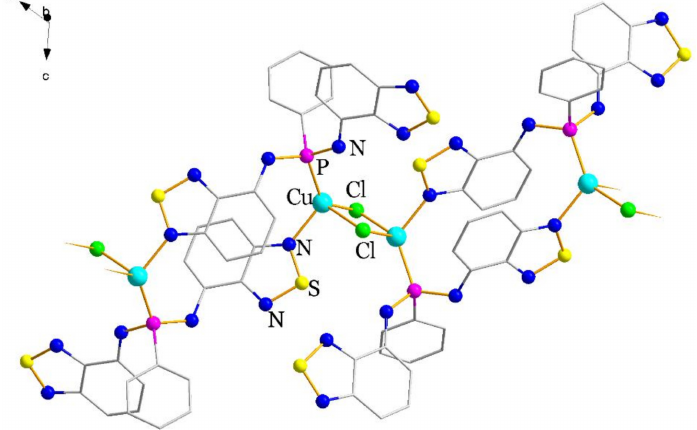
Figure 9. Molecular structure of fragment of 3 . Solvate molecules and hydrogen atoms are not shown. Carbon atoms are shown in “wires and sticks’ mode.